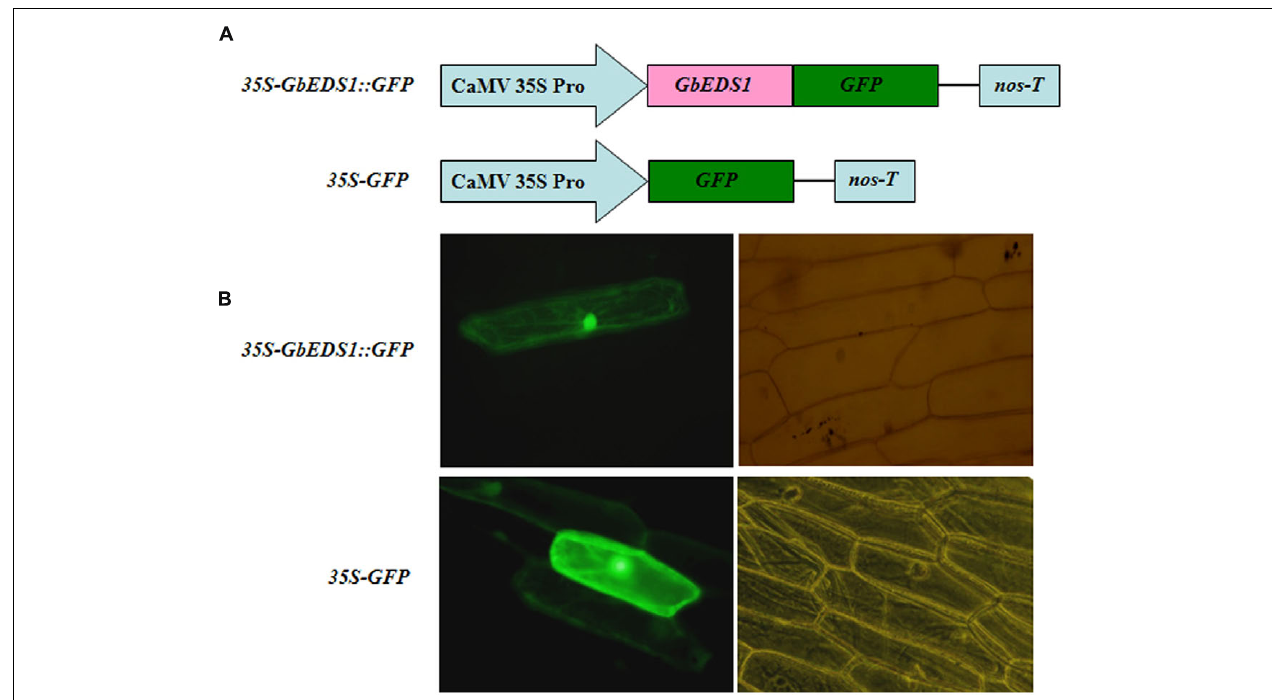
FIGURE 4 | Subcellular localization of GbEDS1 in onion epidermal cells. (A) , Schematic diagram of 35S–GbEDS1::GFP and 35S–GFP fusion construct. (B) , Transient expression of 35S–GbEDS1::GFP and 35S–GFP. Fluorescence images and bright-field images were presented.